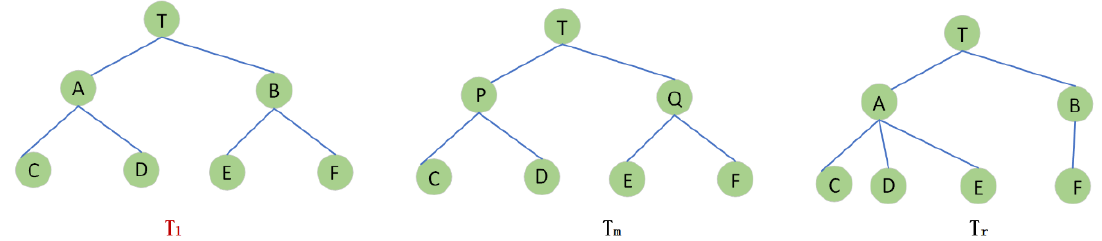
Figure 4. Two common label differences in tree comparisons.